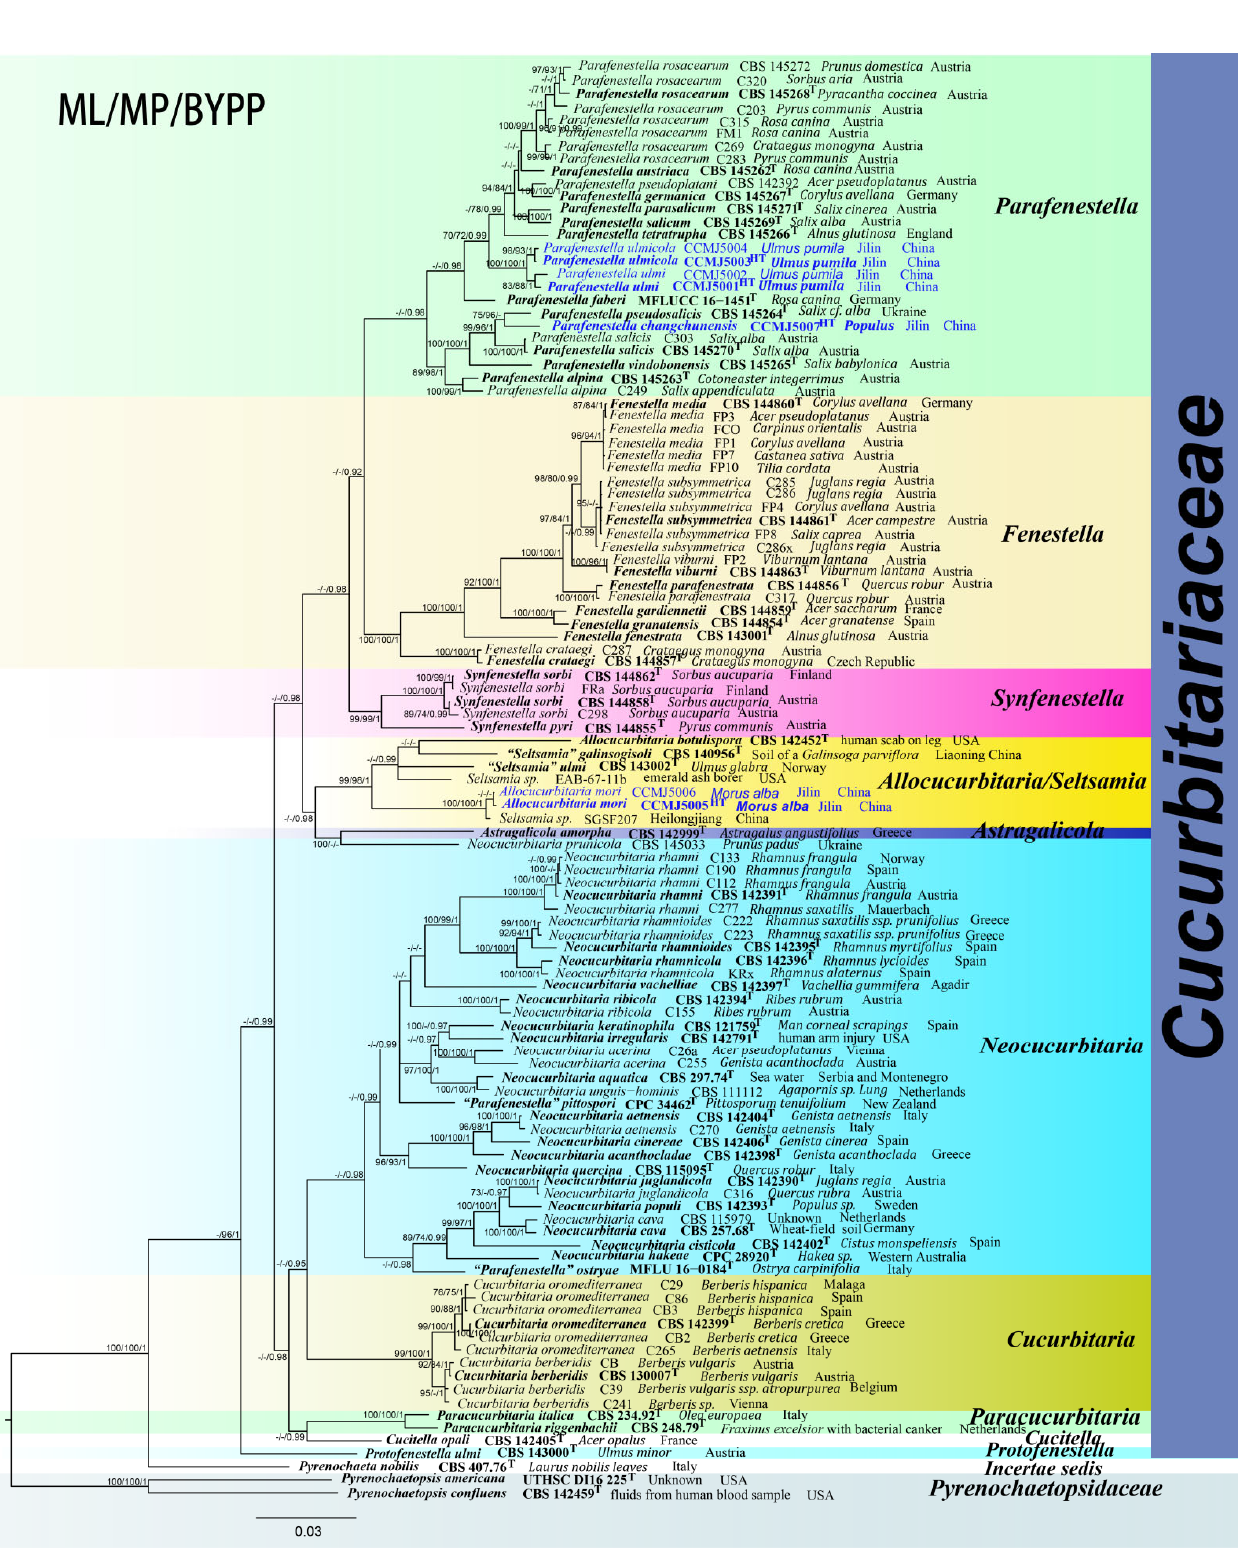
Figure 1. The Bayesian 50% majority-rule consensus phylogram based on a concatenated ITS, LSU, rpb 2, tef 1 - α and β -tub dataset of Cucurbitariaceae . The tree is rooted with Pyrenochaetopsis americana (UTHSC DI16225) and P. confluens (CBS 142459). Bootstrap support values for maximum likelihood and maximum parsimony analysis greater than 70% (ML = left; MP = middle) and Bayesian posterior probabilities ≥ 0.90 (BPP, right) are shown at the nodes. The new species are indicated in blue. The type-derived strains are indicated in bold and marked with T